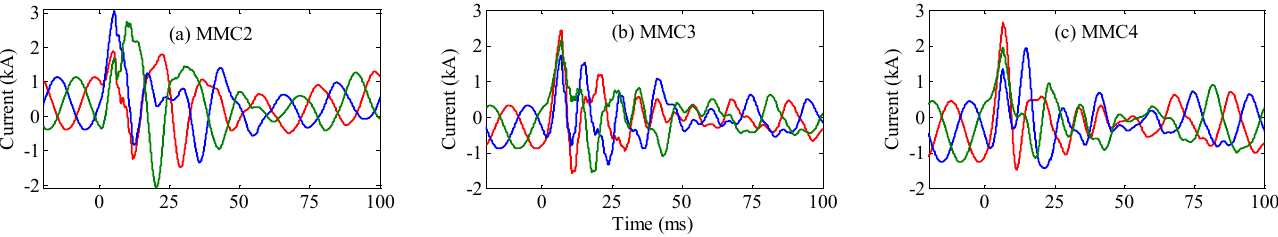
Fig. 11. The arm currents of MMCs in presence of UCBs (communication-based method) (a) MMC2, (b) MMC3, (c) MMC4